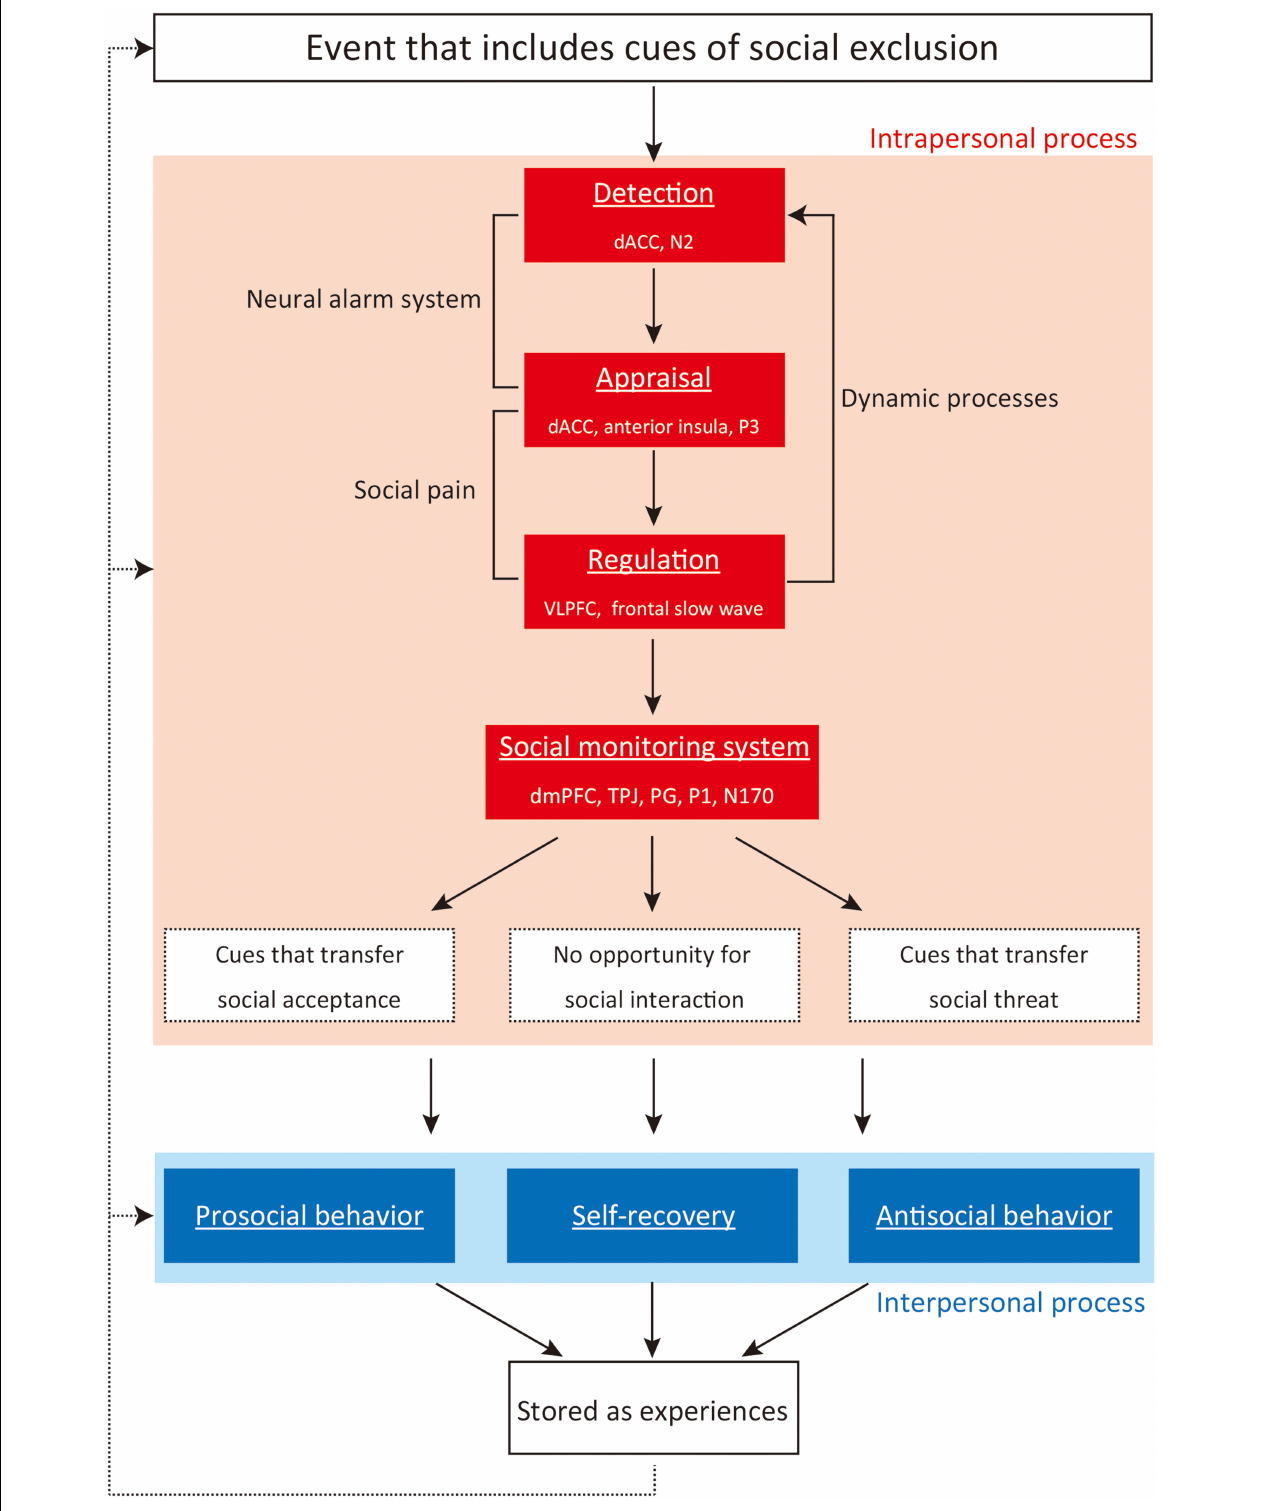
FIGURE 1 | Intrapersonal and interpersonal processes of social exclusion. Note: dACC, dorsal anterior cingulate cortex; VLPFC, ventrolateral prefrontal cortex; dmPFC, dorsomedial prefrontal cortex; TPJ, temporoparietal junction; PG, precentral gyrus.